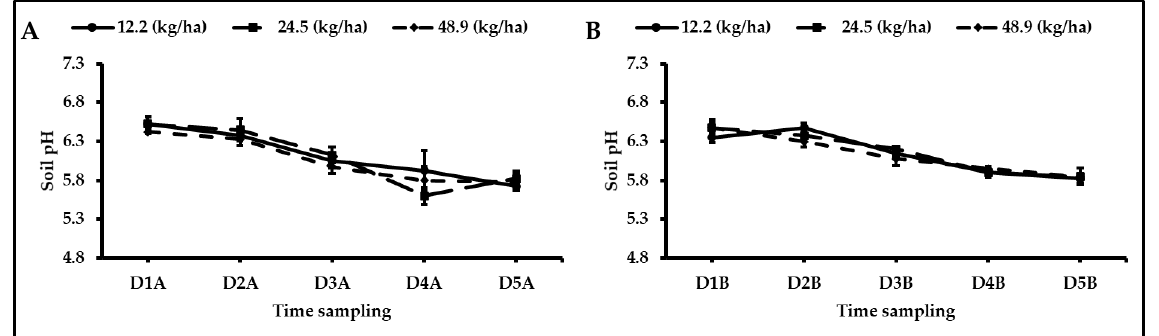
Figure 5. Soil pH of two farms (Farm ( A ); Farm ( B )) with different P fertilizer application rates (12.2 kg P ha −1 ; 24.5 kg P ha −1 ; and 48.9 kg P ha −1 ) in the year 2020. Each D represents a date: D1A = 13 December 2019; D2A = 3 February 2020; D3A = 17 February 2020; D4A = 2 March 2020; D5A = 6 April 2020; D1B = 9 December 2019; D2B = 3 February 2020; D3B = 17 February 2020; D4B = 2 March 2020; and D5B = 6 April 2020. Error bars exhibit the standard error of the mean from four replicates of the measurements.